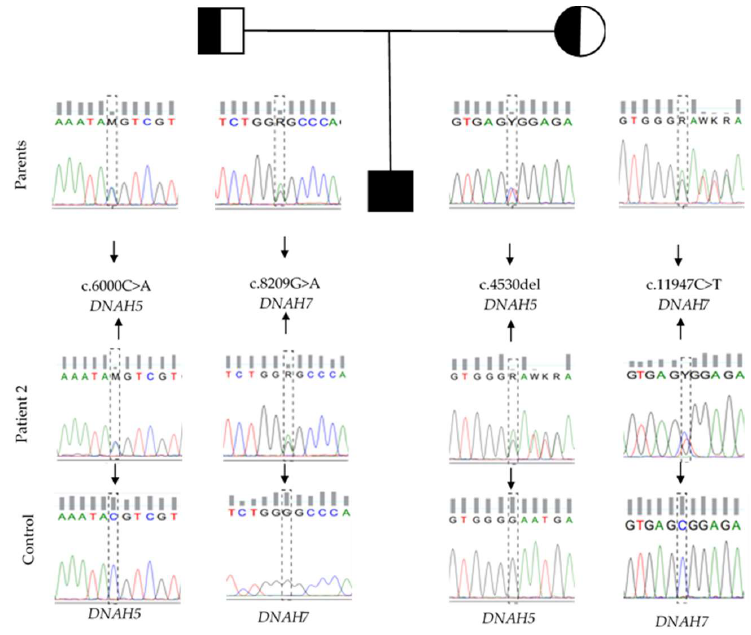
Figure 2. Pedigree and sequencing electropherograms of the variants in genes DNAH5 and DNAH7 identified in this study.